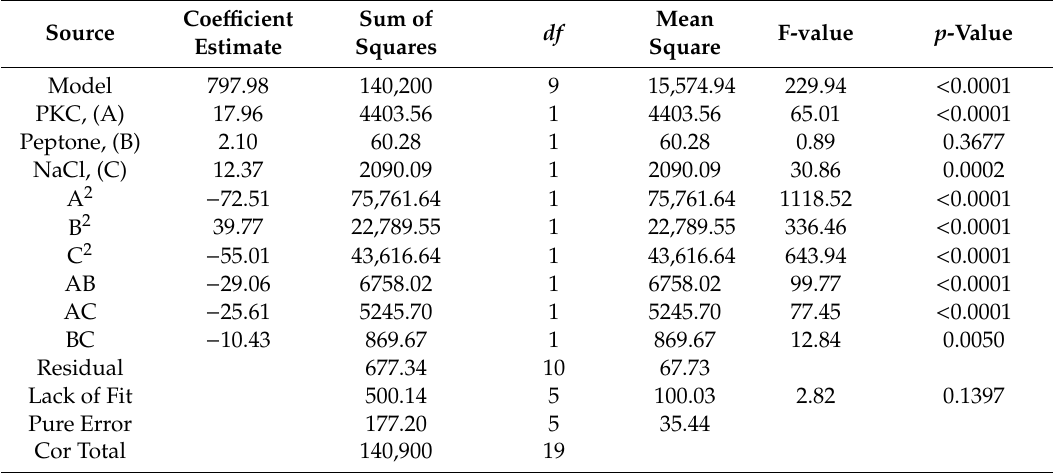
Table 6. Analysis of variance (ANOVA) and coe ffi cient estimate (CE) using a regression model for the optimization of β -mannanase production by B. subtilis ATCC